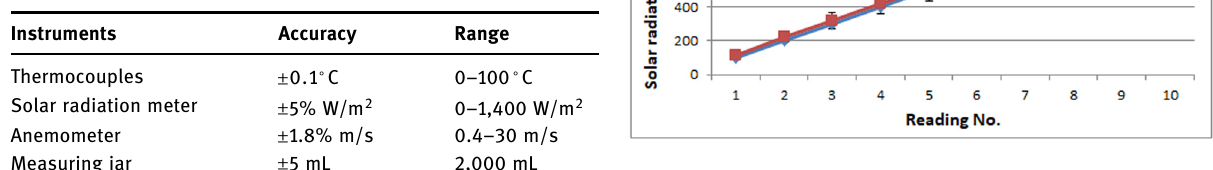
Figure 5: Calibration for